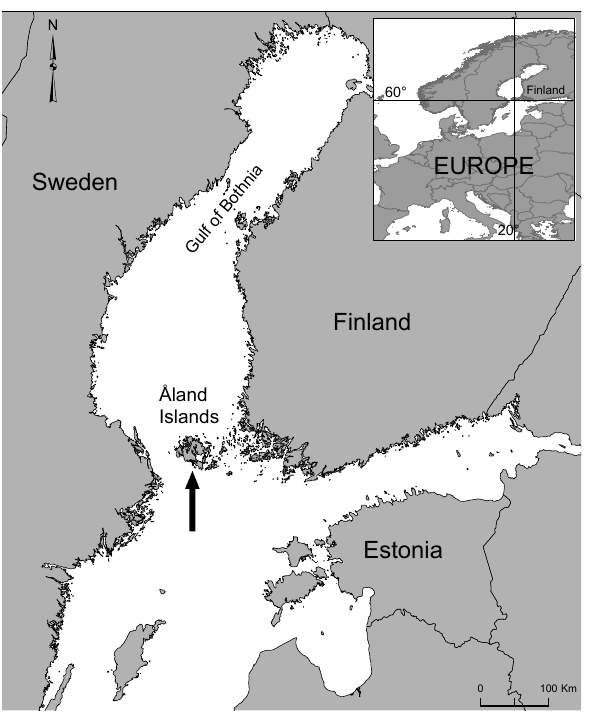
Fig.1. The sampling site of whitefish, Coregonus lavaretus , off Kobba Klintar, Mariehamn, Åland Islands (arrow) The Gulf of Bothnia stretches ~750 km from the Åland Islands in the south, to the Tornio region in the north. In the southern part of the gulf, the Åland Islands and the Archipelago Sea are facing the Baltic proper.